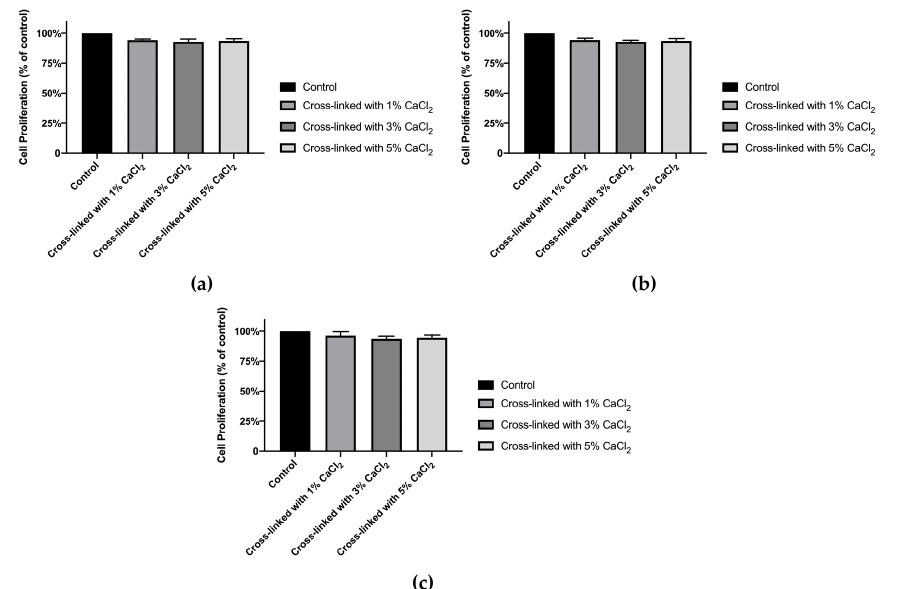
Figure 5. The cytotoxicity test was performed using a microplate reader (optical density (OD): 450 nm). ( a ) graph obtained from 5% ( w/v ) alginate/CMC/PEO nanofiber film. ( b ) graph obtained from 7% ( w/v ) alginate/CMC/PEO nanofiber film. ( c ) graph obtained from 9% ( w/v ) alginate/CMC/PEO nanofiber film.